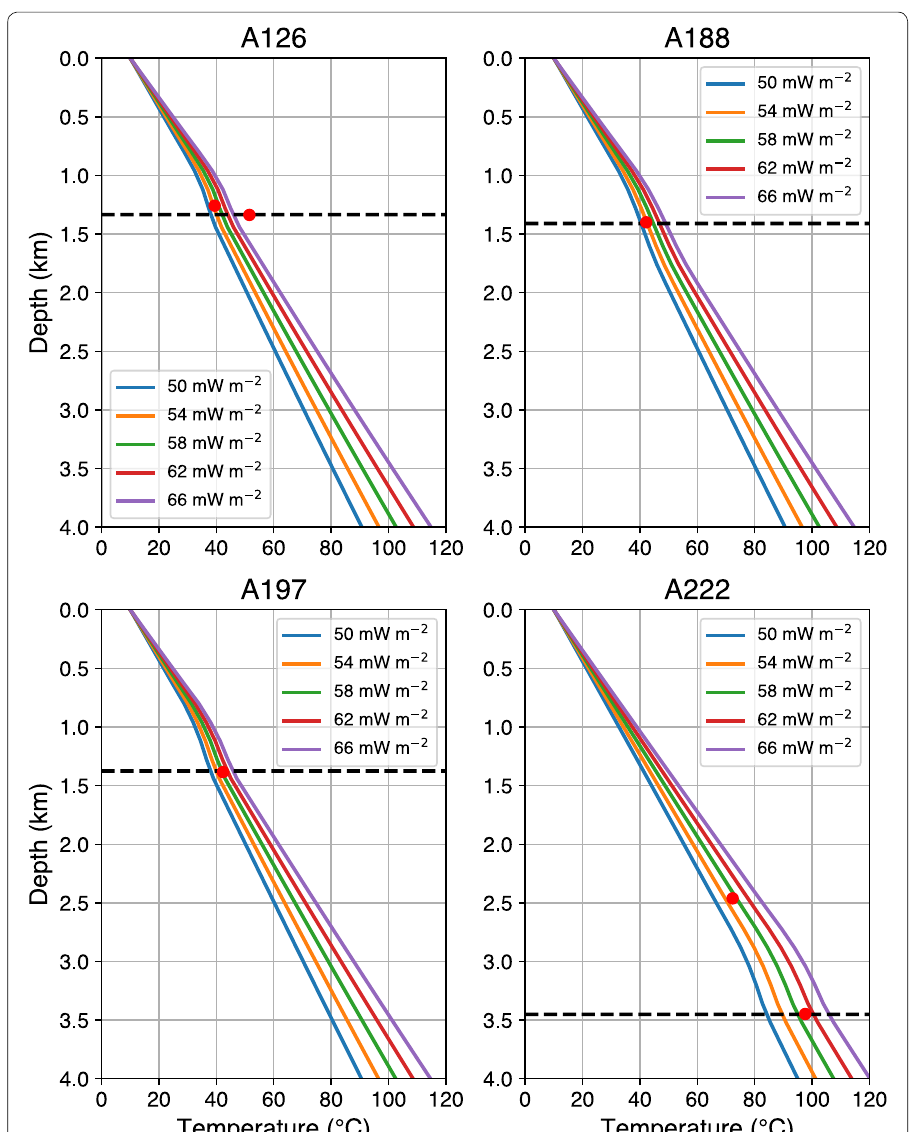
Fig. 12 Temperature profiles in wells. Temperature profiles in wells A126, A188, A197, and A222 for different heat flow conditions at the bottom boundary of Model 1 (dashed line indicates basement depth; red solid circles represent temperature after Harrison’s